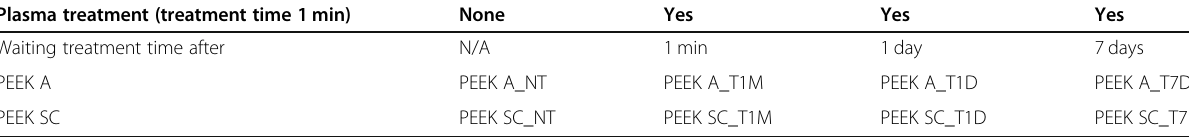
Table 1 Description of performed treatments condition on the thermoplastic interlayer Plasma treatment (treatment time 1 min)